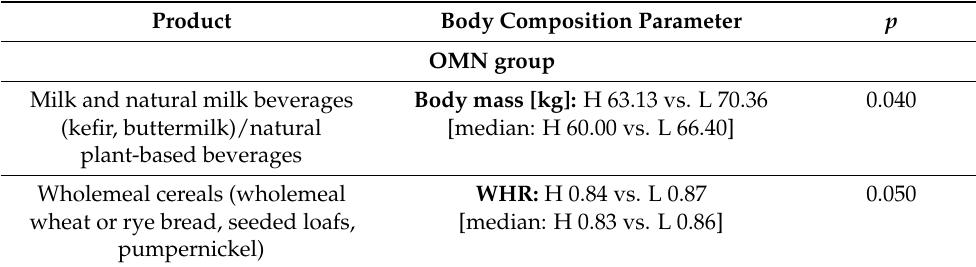
Table 9. Relationships between the parameters of body composition analysis and the high and low frequency of food consumption in the studied groups. The data included only statistically significant